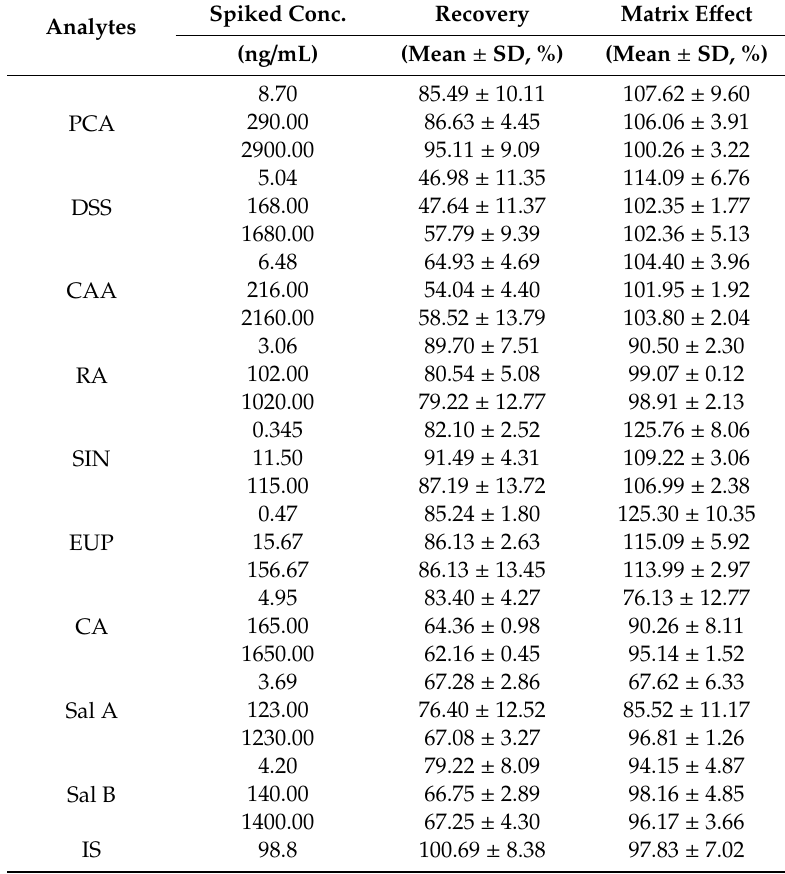
Table 3. Extraction recoveries and matrix e ff ects of the nine analytes in rat plasma ( n = 6). Spiked Conc. Analytes